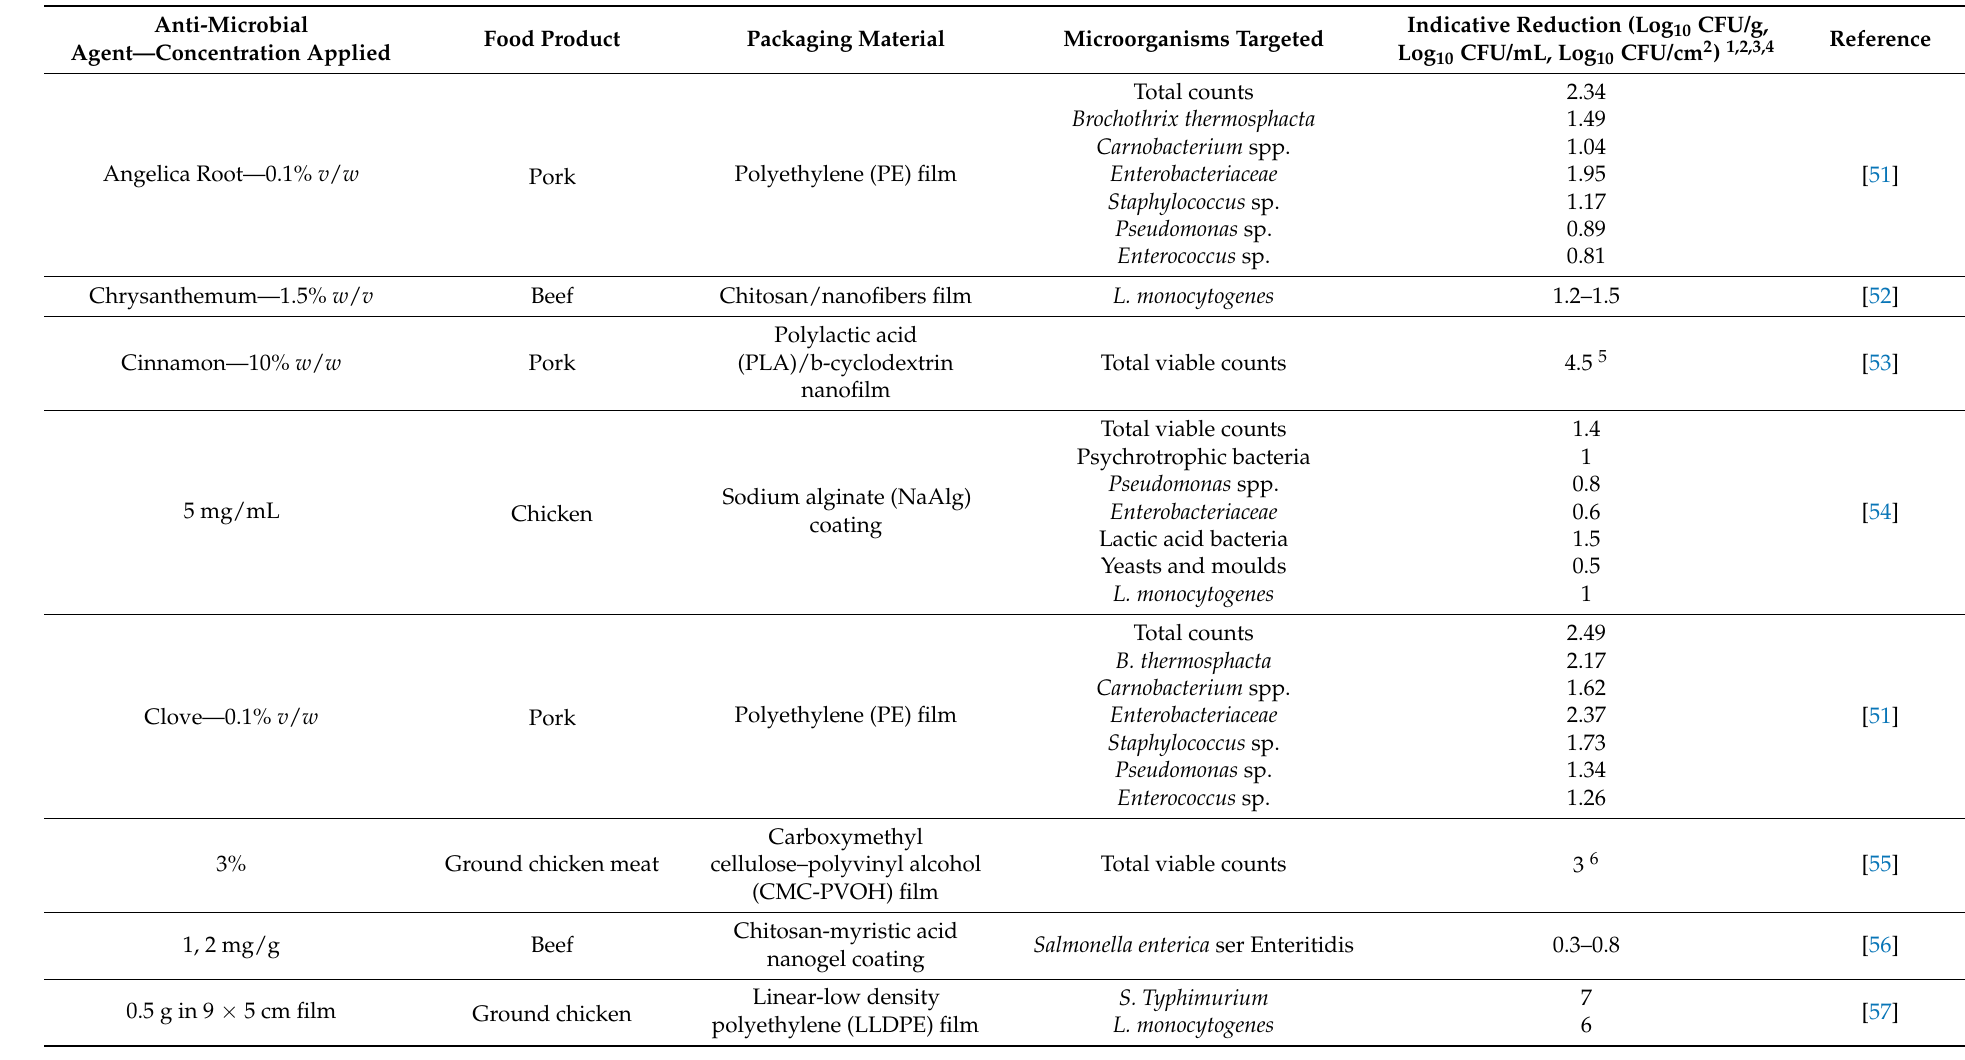
Table 2. Overview of studies testing the efficacy of anti-microbial packaging with essential oils and plant extracts or their components on meat products.